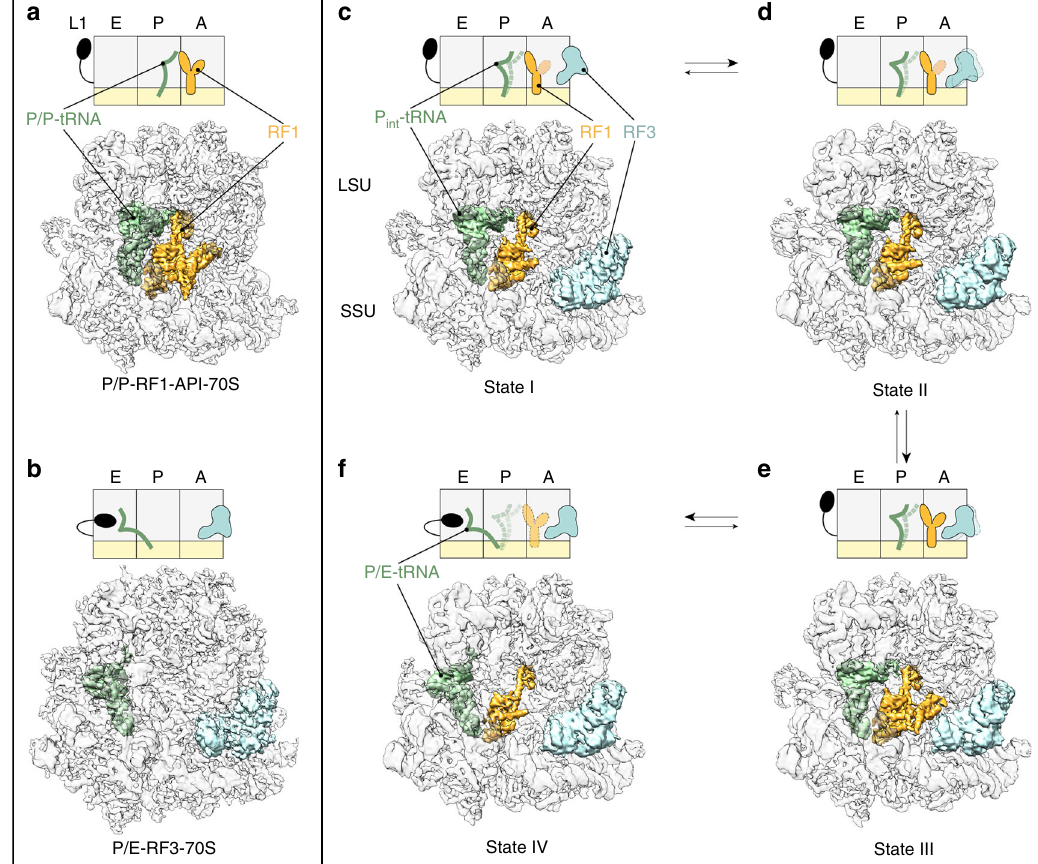
Fig. 1 Structures of RF1- and RF3-containing termination complexes. a – f Schematic representation (above) and electron density (below) for termination complexes containing a RF1 (orange) stalled by API on a non-rotated ribosome with a classical P/P-site tRNA (green) 26 , b RF3 (cyan) trapped by GDPCP on a rotated ribosome with hybrid P/E-site tRNA 28 , c – f state I – IV with RF1-GAQ (orange), RF3-GDPCP (cyan) bound to c – e partially rotated ribosomes with intermediate P-site (P int ) tRNA (green) or f a fully rotated ribosome with a hybrid P/E-site tRNA (green). In the scheme, the SSU and LSU are coloured yellow and grey, respectively, with A-, P- and E-sites and the L1 stalk indicated, whereas fl exible regions are indicated by increased transparency. In the map overviews, the electron density for the SSU and LSU has been fi ltered locally and is shown as a grey transparency so that the ligands can be easily seen within the